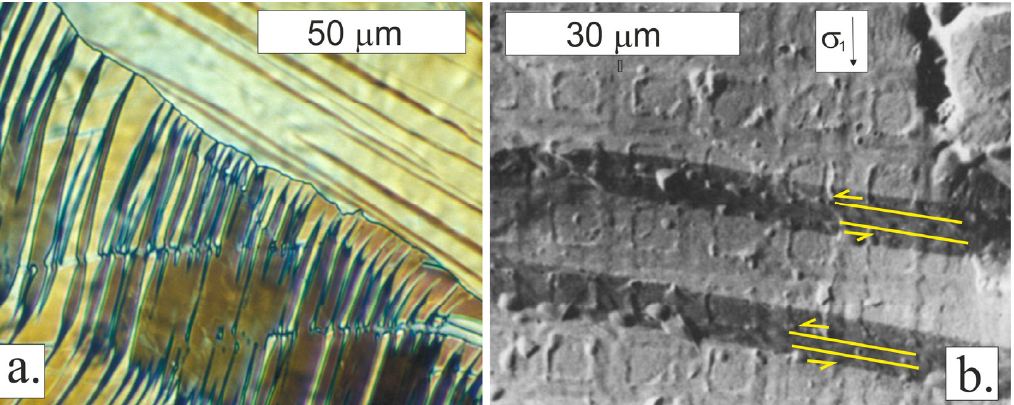
Figure 10. ( a ) Optical micrograph of Carrara marble (crossed polars) experimentally shortened 27% at 420 °C then annealed under hydrostatic pressure at 600 °C, showing thickening of initially thin twins by twin boundary migration without strain. This leads to irrational twin boundaries especially near the host grain boundaries, where they pinch to avoid introducing steps to the host grain boundaries (image: Dr. S. J. Covey-Crump); ( b ) Surface of a calcite grain in Carrara marble, polished and impressed with a 10 μ m grid before deformation at 700 °C to reveal strain heterogeneities. Two twin lamellae show shear of the grid where the twins nucleated, plus dynamic migration of the twin boundary without strain.